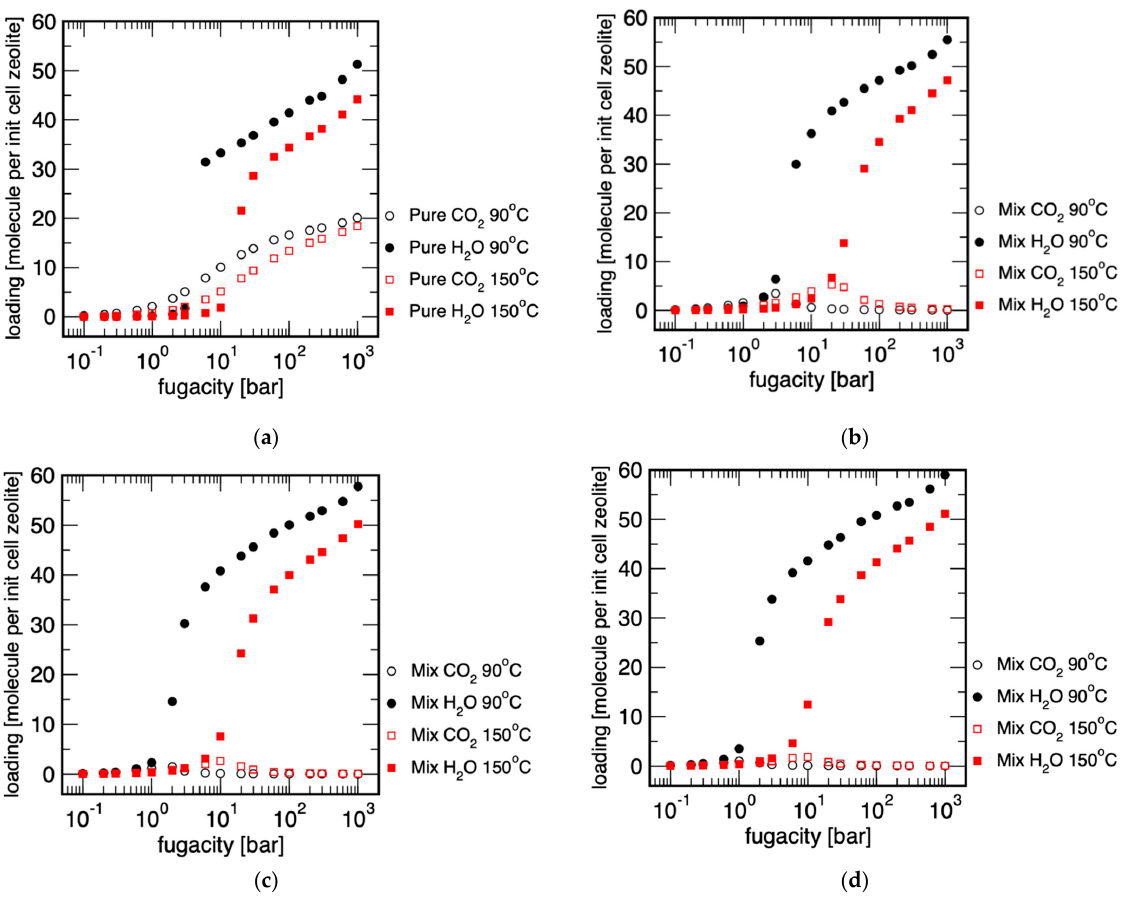
Figure 5. Adsorption isotherms of ( a ) pure and H 2 O/CO 2 mixture ratios of ( b ) 0.3, ( c ) 0.7, and ( d ) 1.0 in an MFI unit cell at 90 °C and 150 °C calculated from grand canonical Monte Carlo simulations.